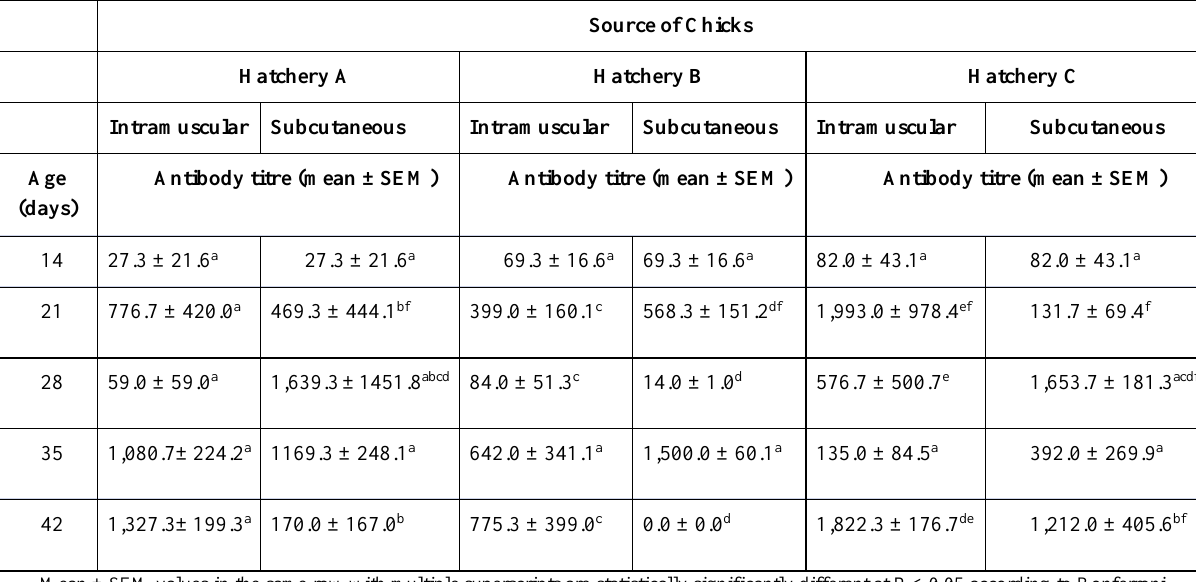
Table 4. Effects of 0.5 ml of avian influenza H5 vaccine administered at 14 and 28 days of age via either intramuscular or subcutaneous